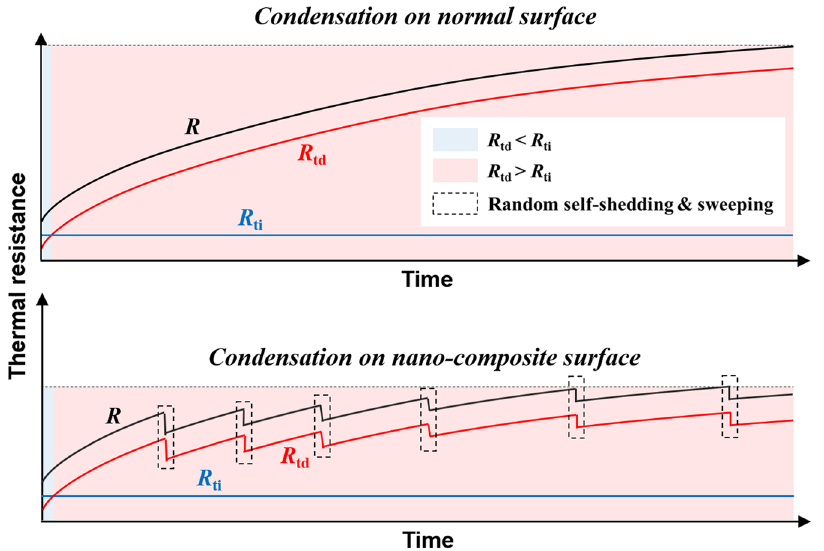
Figure 5. Schematic presentation of the mechanism of self-shedding and sweeping on composite nano-surface to enhance condensation heat